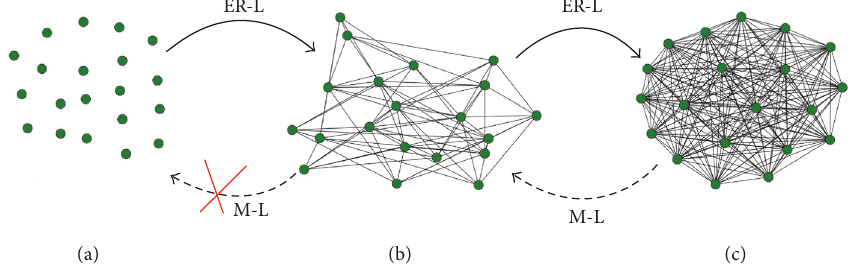
Figure 1: Pictorial representation of a dilution process implemented via the ER-L strategy (continuous line) and via the M-L strategy (dashed line). Labels (i.e., (a), (b), and (c)) indicate three different phases of the graph. Arrows indicate the direction of the process. The M-L strategy cannot lead to phase (a), as indicated by the red cross on the related arrow. Here, spin values are not represented (i.e., all nodes have the same